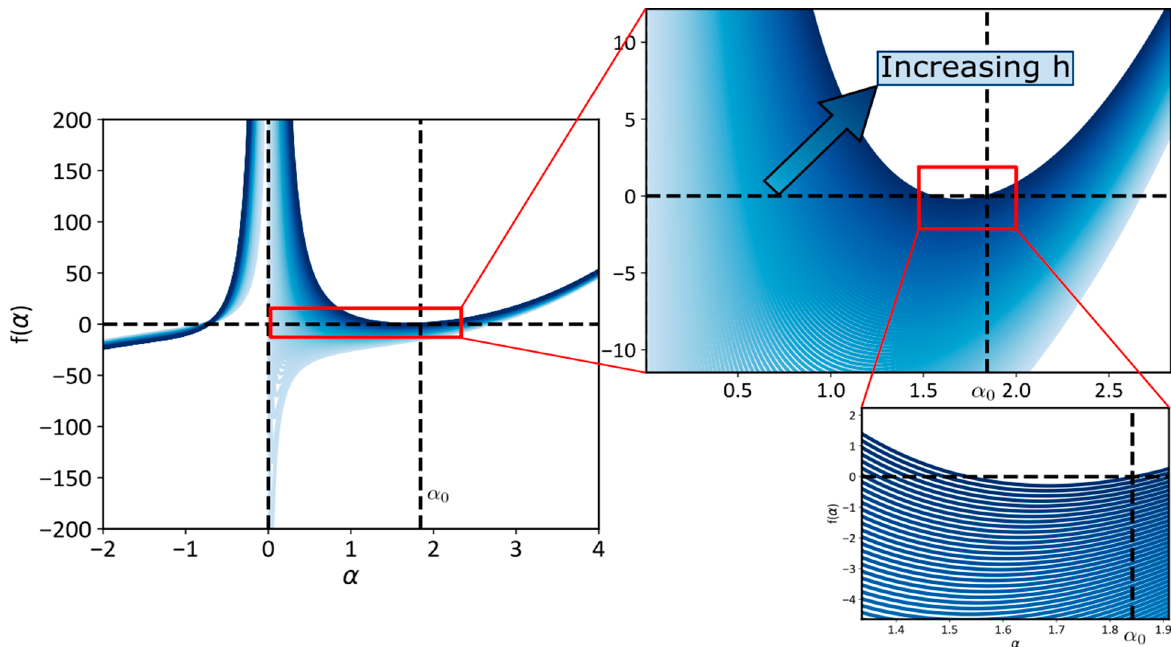
Figure A1. Variation of the equilibrium condition for 𝐴(cid:3427)𝐻 , 𝑧 , 𝜙 (cid:3043) (cid:3431) Equation (10) for increasing particle separation, h (from light to dark blue). The darkest line represents h = 1.09 L. For h > 1.09 L there are no positive roots for f( α ) and thus no solutions for the equilibrium condition.